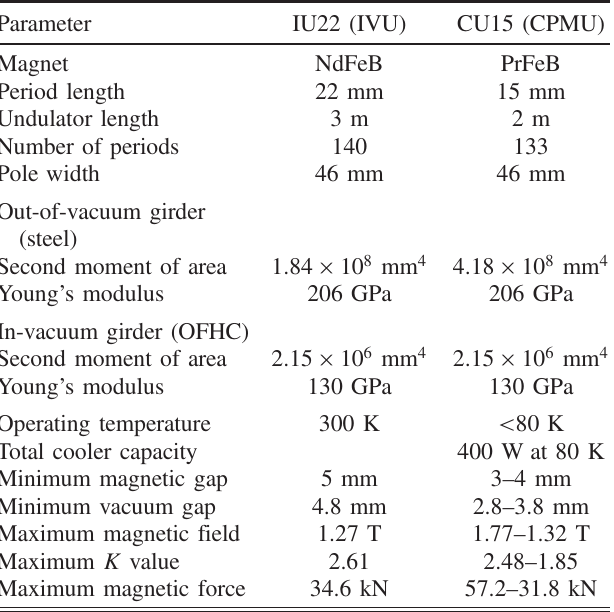
TABLE I. CPMU and IVU parameters at